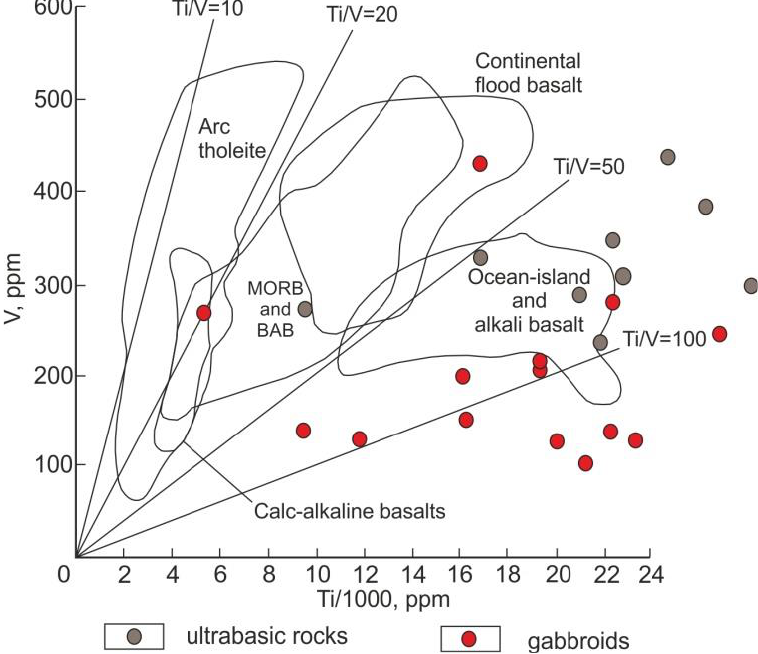
Figure 18. V vs. Ti/1000 diagram for ultrabasic and basic rocks of the Tommot massif. Fields and trends after [67].